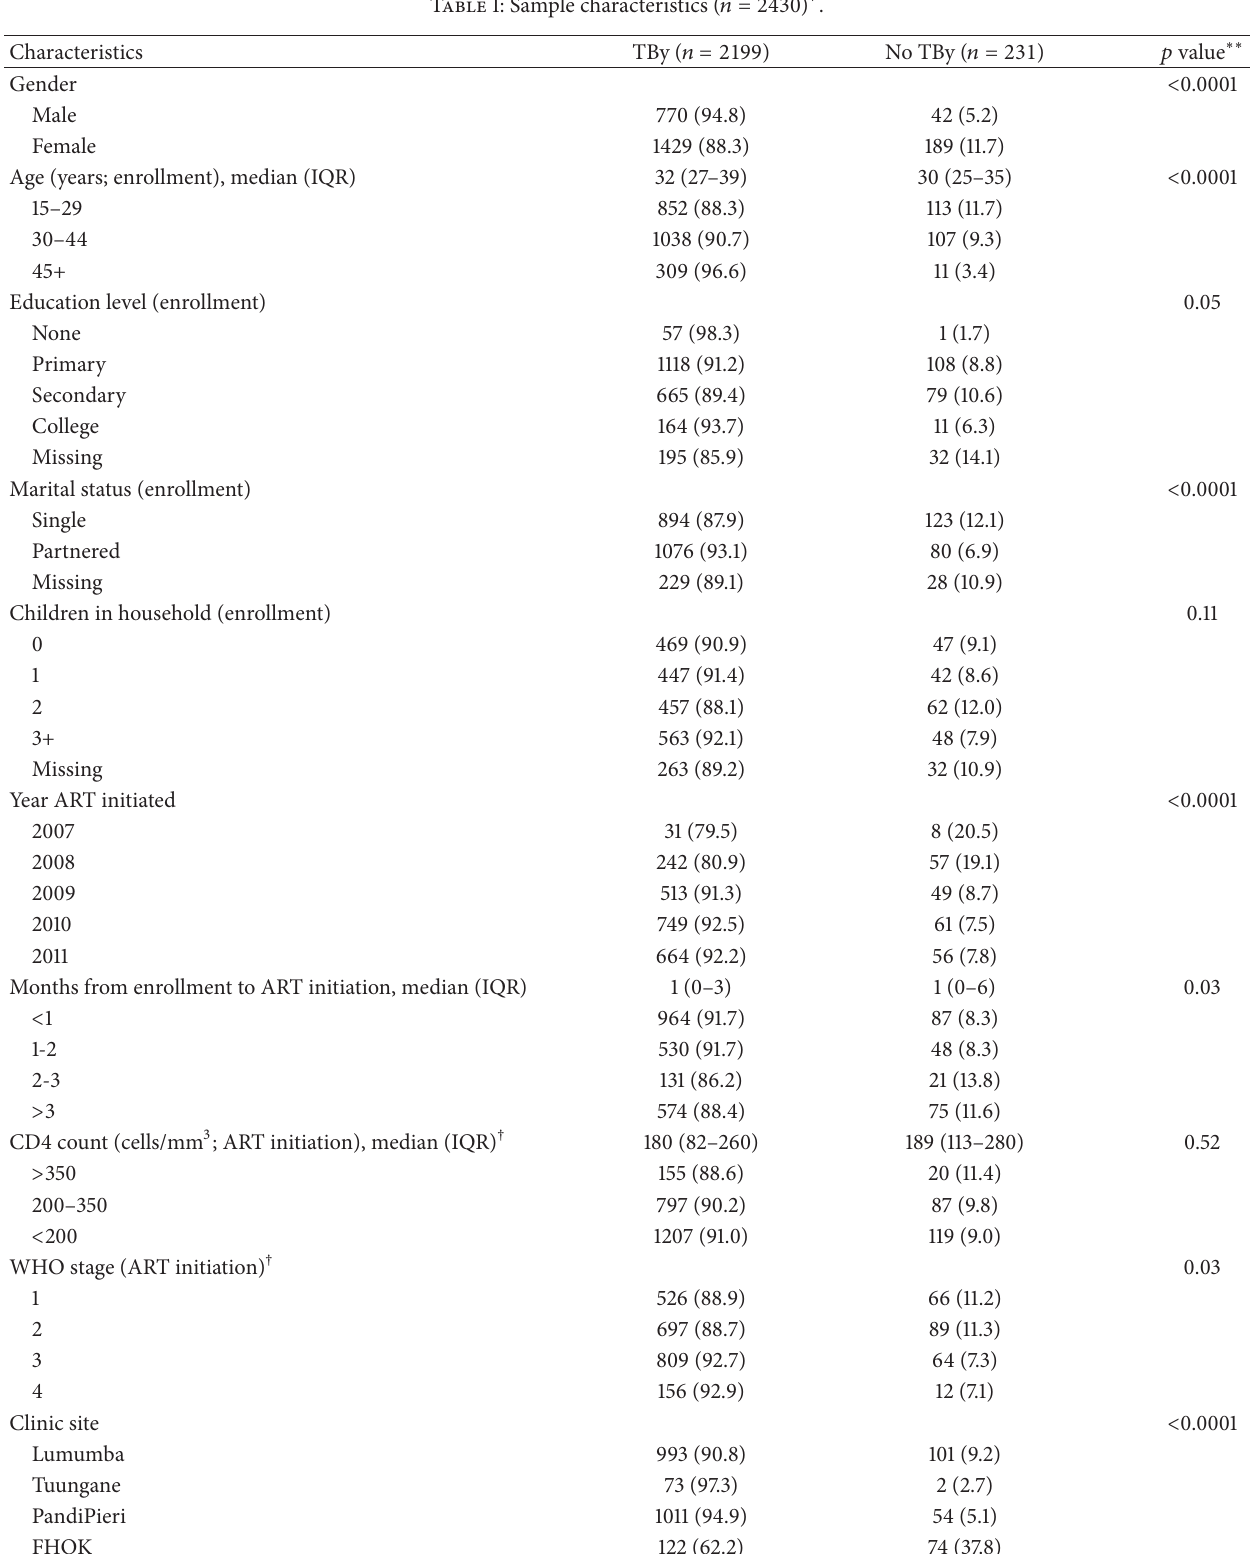
Table 1: Sample characteristics ( 𝑛 = 2430 ) ∗